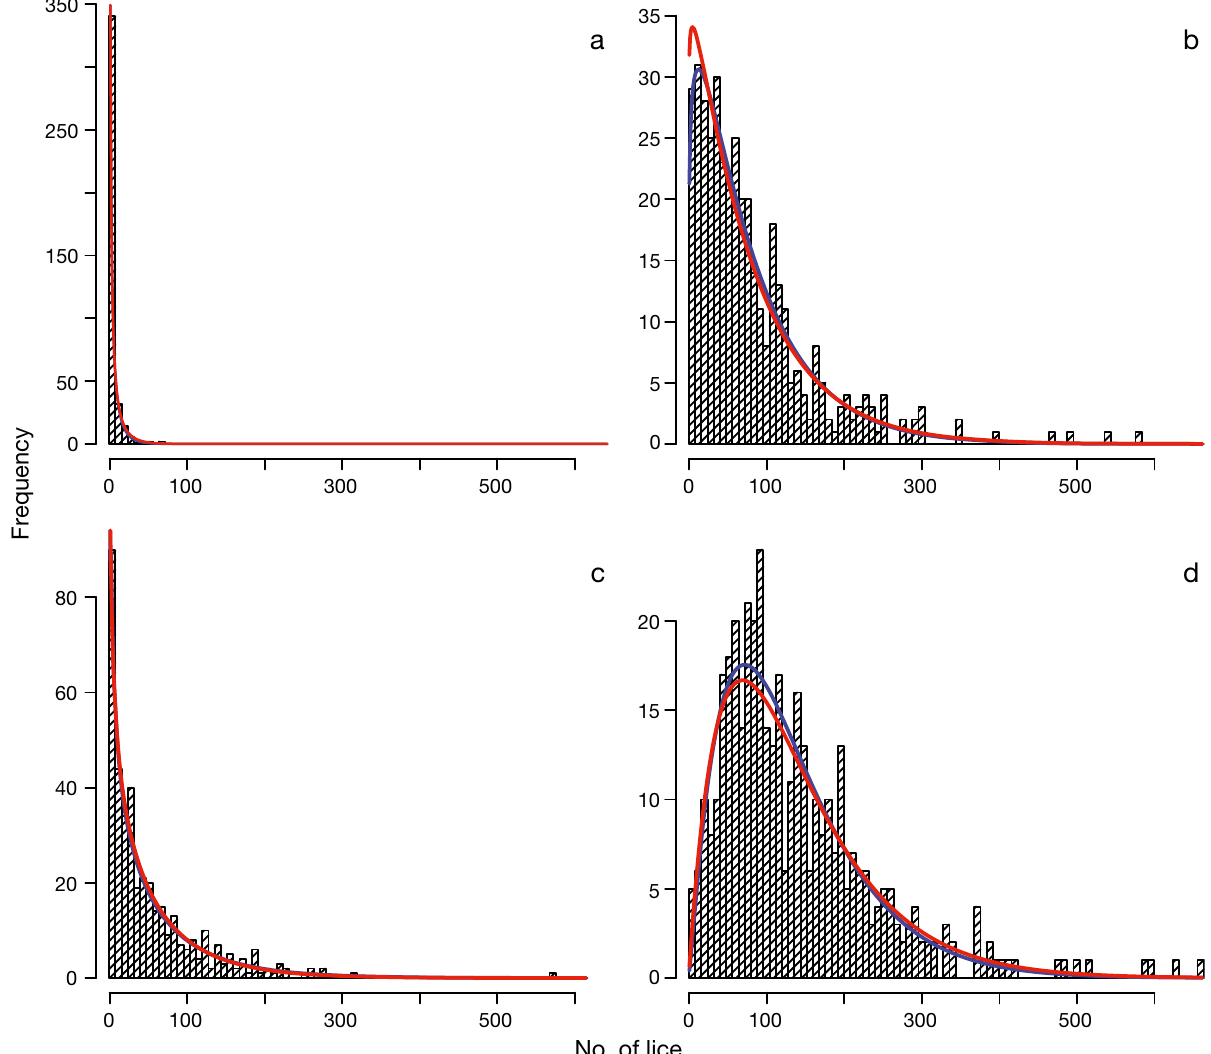
Fig. 2. (a,b,c) Weekly lice infestations for Weeks 1 to 3, respectively, and (d) the total accumulated lice abundance distribution after the 3 weeks. Expected means for the 3 weeks are 4, 80 and 54, respectively, and 138 for the total distribution. Red lines: distributions used for the simulation from and the theoretical distribution for the 3 week accumulated distribution; blue lines: negative binomial distributions fitted directly to the simulated samples (only visible in panels b and